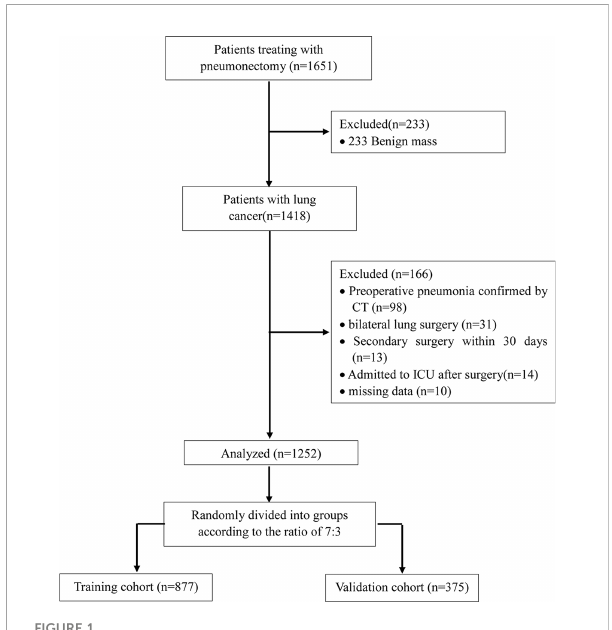
FIGURE 1 Flow chart of patients screening and